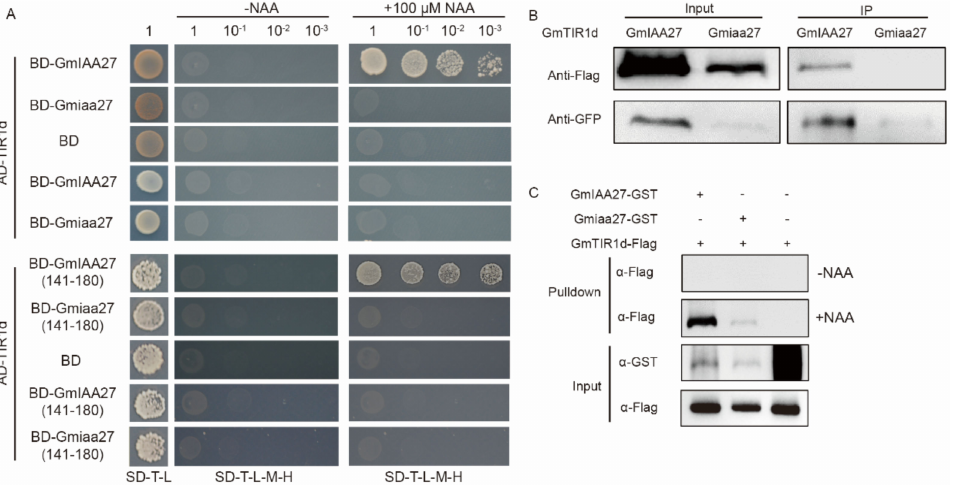
Figure 8. In vitro and in vivo interaction between GmIAA27/Gmiaa27 and GmTIR1d. ( A ) GmIAA27 and domain II of GmIAA27 (141-180) interacts with TIR1d in yeast cells with 100 µ M NAA. SD/-T-L, selective medium lacking Trp and Leu; SD/-T-L-H-A, selective medium lacking Trp, Leu, His, and Ade. ( B ) Co-immunoprecipitation assays showing that GmIAA27 interacts with TIR1d in plant tobacco cells. ( C ) Pull-down assays showing that GmIAA27 interacts with TIR1d with 100 µ M